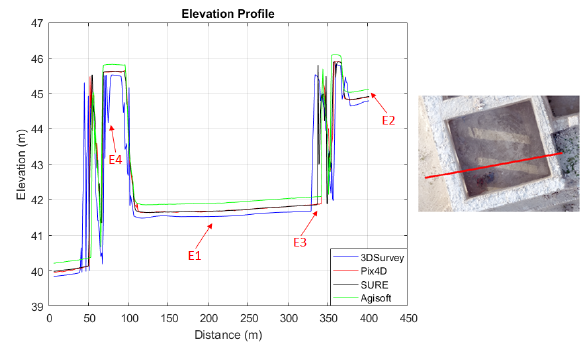
Figure 7. Elevation profiles on DSMs at edges